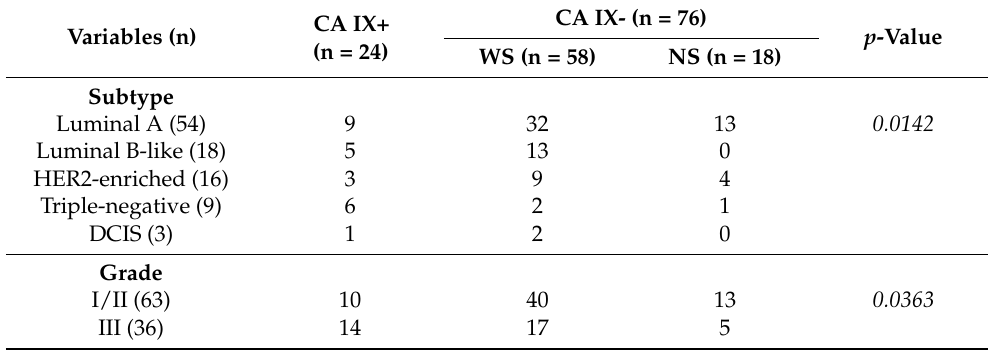
Figure A2. Analysis of sCA IX levels in plasma of patients with CA IX nuclear positivity in tumor tissue. Violin graphs with dots (plot all data) showing the levels of sCA IX in groups CA IX − positive versus CA IX − negative versus CA IX − negative with nuclear signal (determined by IHC). Table displaying summary statistical data for each group: number of patients (n), mean with 95% confidence interval (CI) for mean, median with 95% CI for median, number of patients with sCA IX level above the cut off, and p -value (Kruskal–Wallis test with Dunn’s post hoc test). Table A1. Association of nuclear CA IX expression with clinicopathological